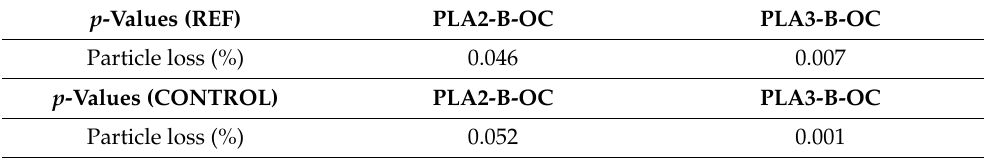
Table 12. p -values of particle loss test.